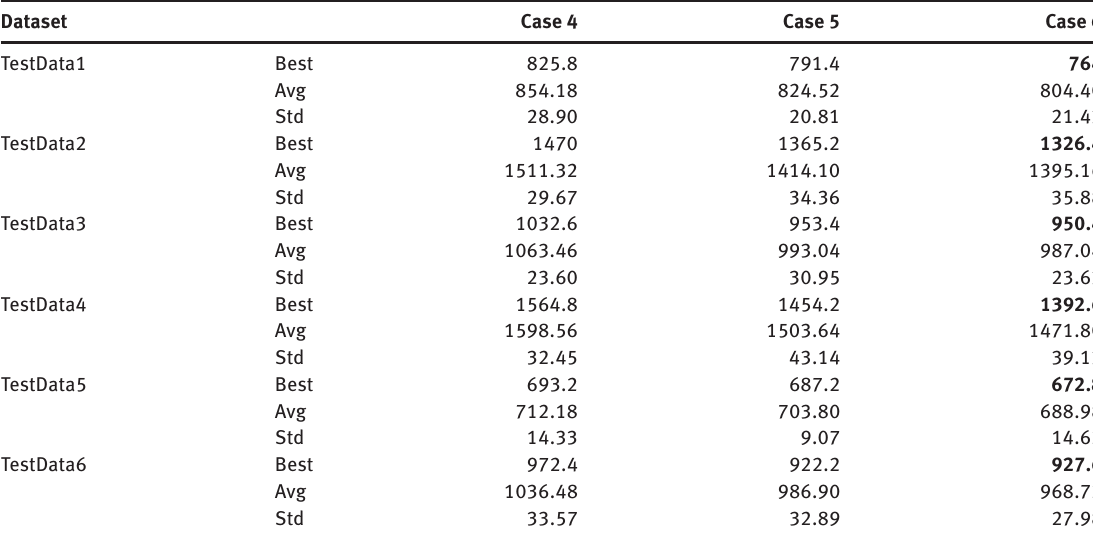
Table 5: Results of Studying PAR Parameter.